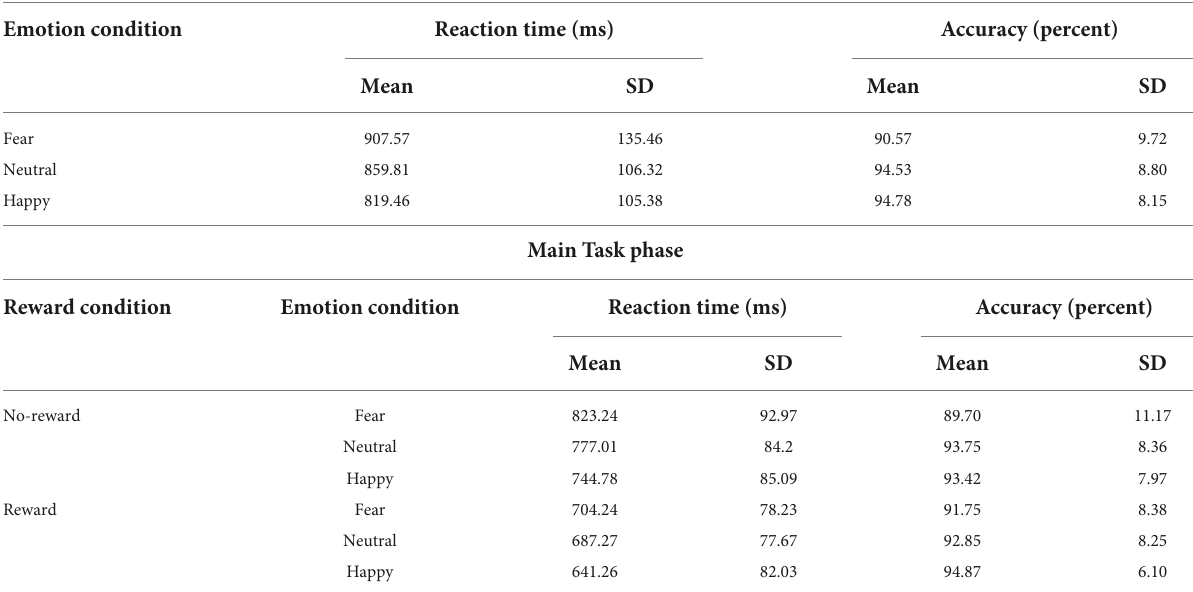
TABLE 1 Descriptive RT and accuracy values from Experiment